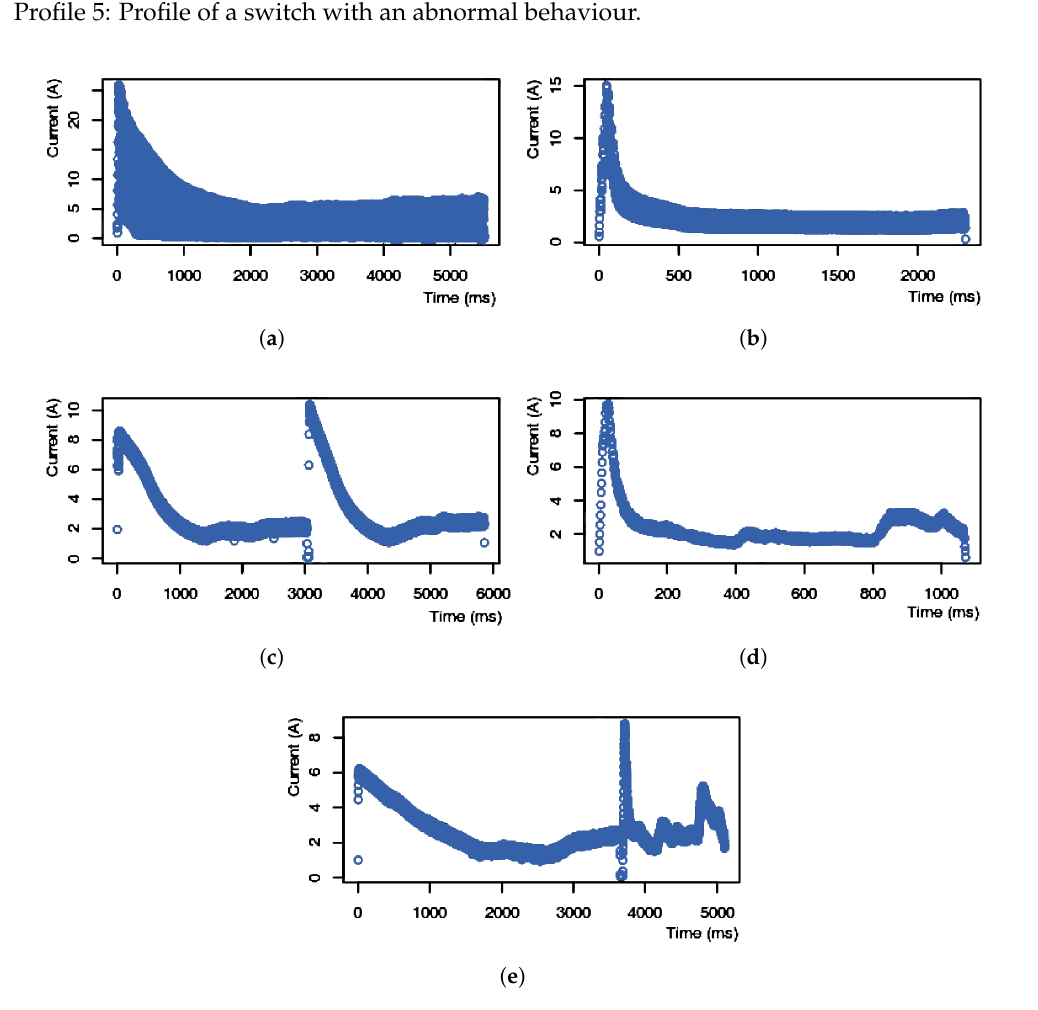
Figure 2. Identified current profiles: ( a ) Profile 1, ( b ) Profile 1, ( c ) Profile 3, ( d ) Profile 4, and ( e ) Profile